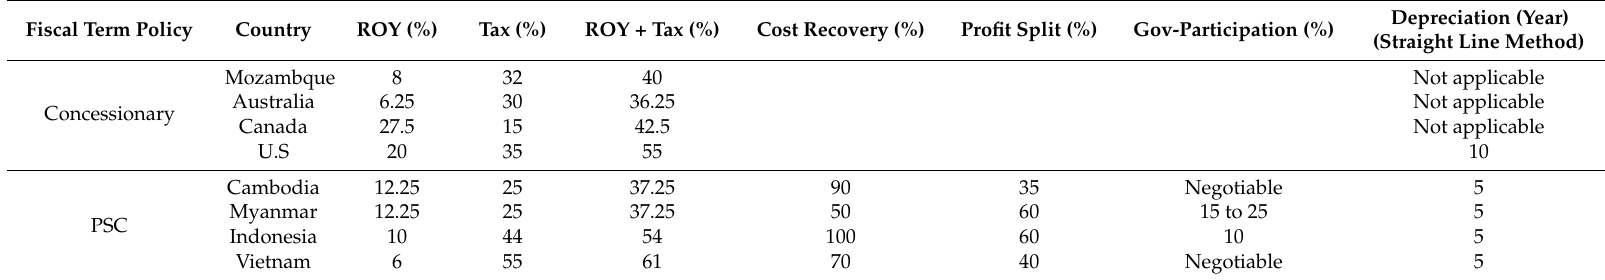
Table 6. Summary of Main Fiscal Parameters in Concessionary and